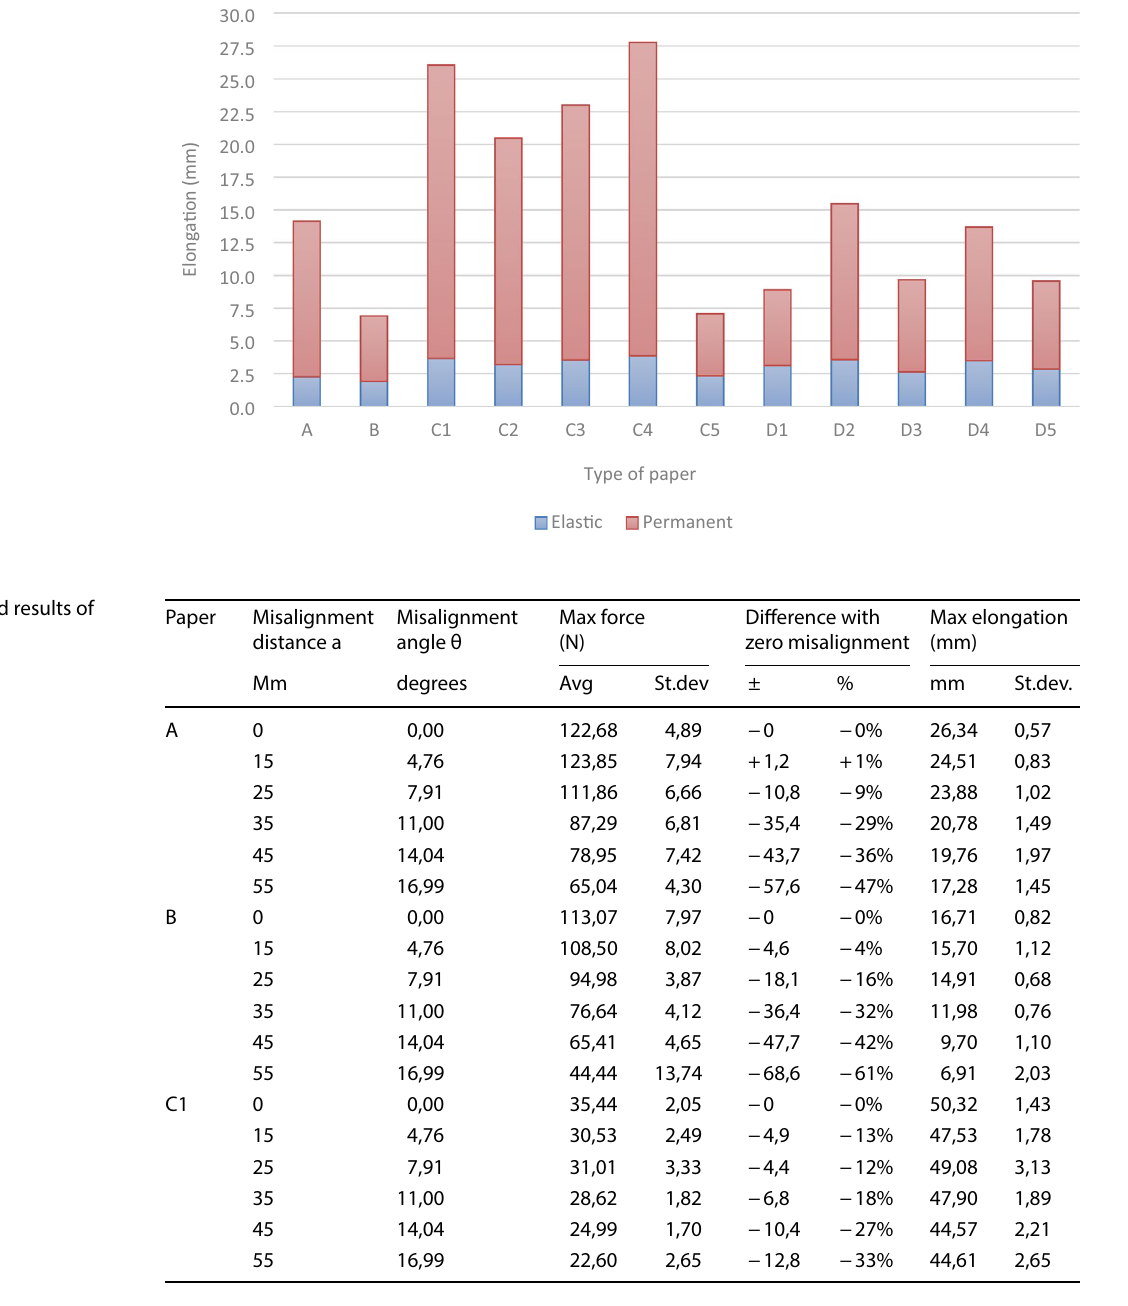
Fig. 9 Elongation for each paper at 50% of their breaking load